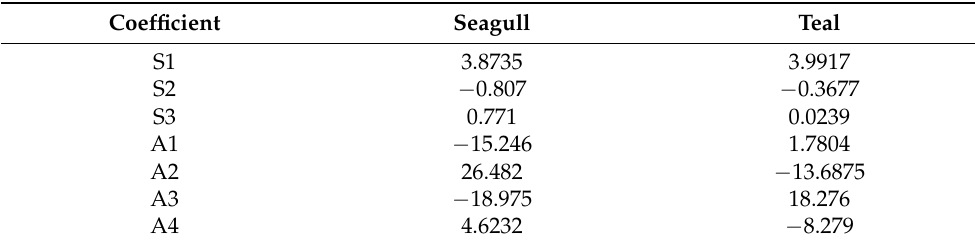
Table 1. Coefficient distribution of bionic airfoil.